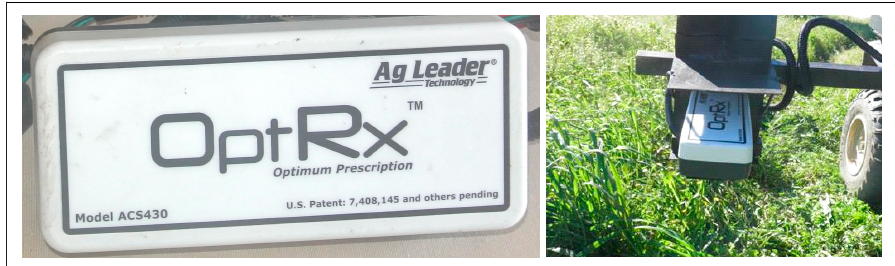
Figure 9. Active o ptical sensor “OptRx TM ” used to measure NDVI.